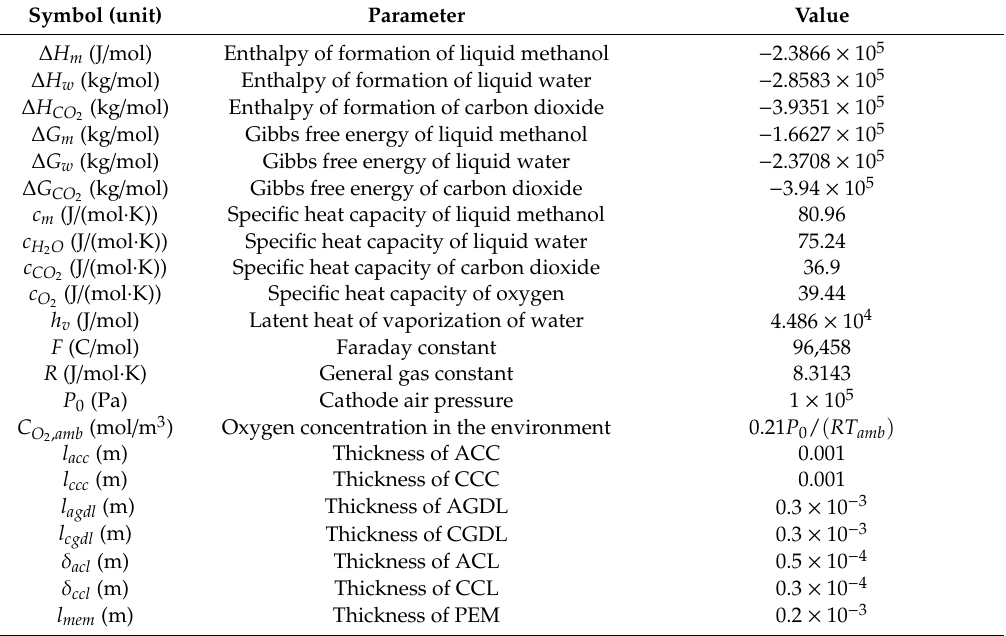
Table 1. Physical parameters used in the